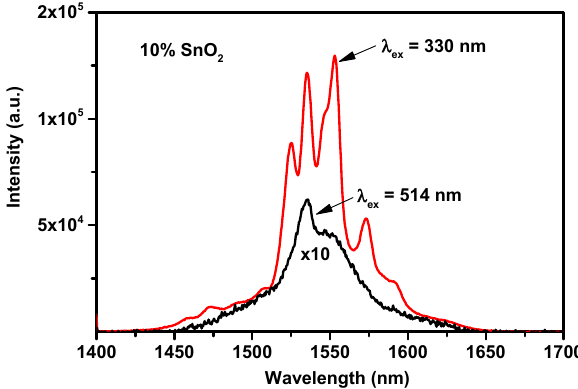
Figure 3. Emission spectra of 90SiO 2 -10SnO 2 :0.5Er 3+ monolith heat treated at 900 °C for 40 h excited at 330 nm and 514 nm by using a Xenon lamp as an excitation source.